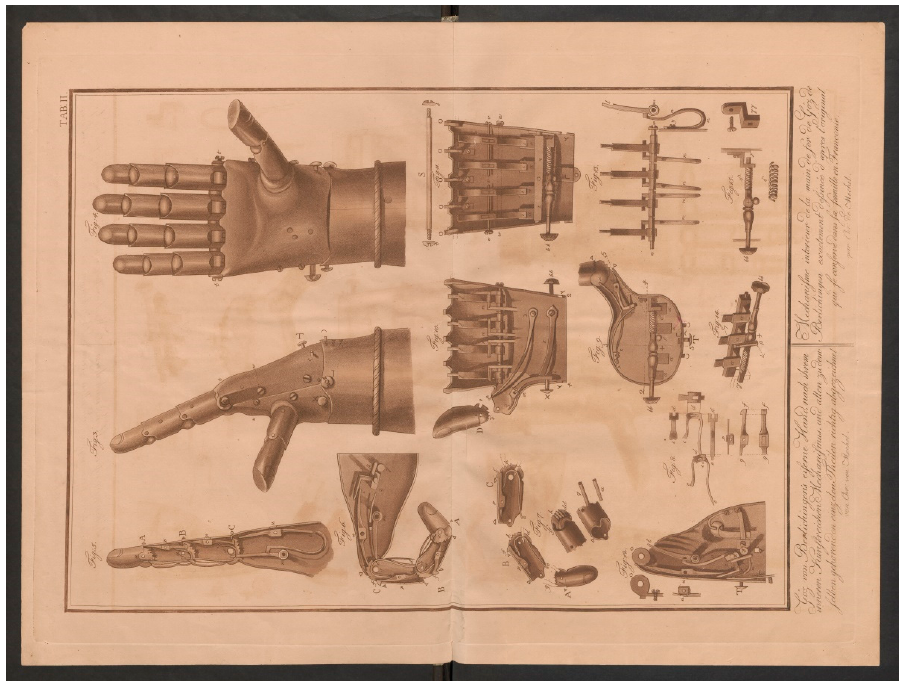
Figure 2. Götz von Berlichingen´s second “Iron Hand”—overview of the mechanism of the fingers.